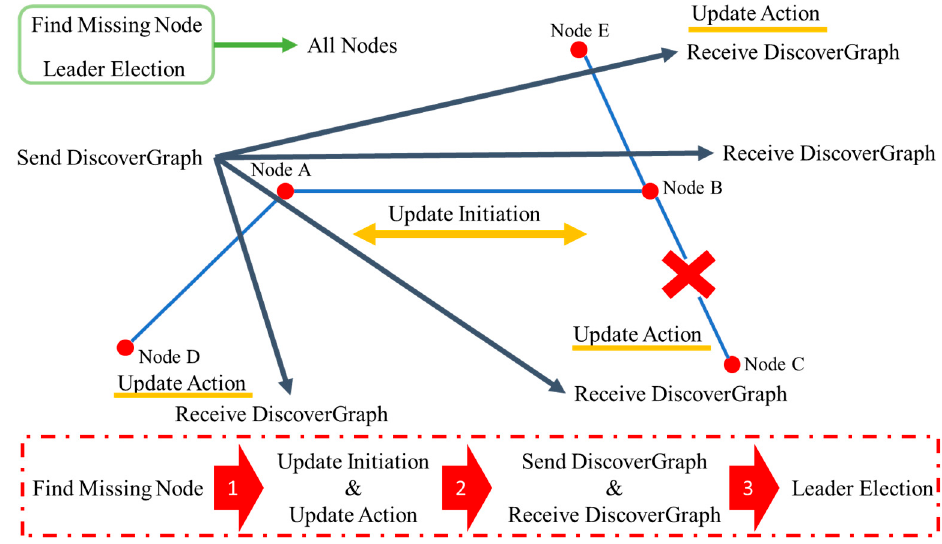
Figure 5. Sequence of algorithms for discovering power system topology.